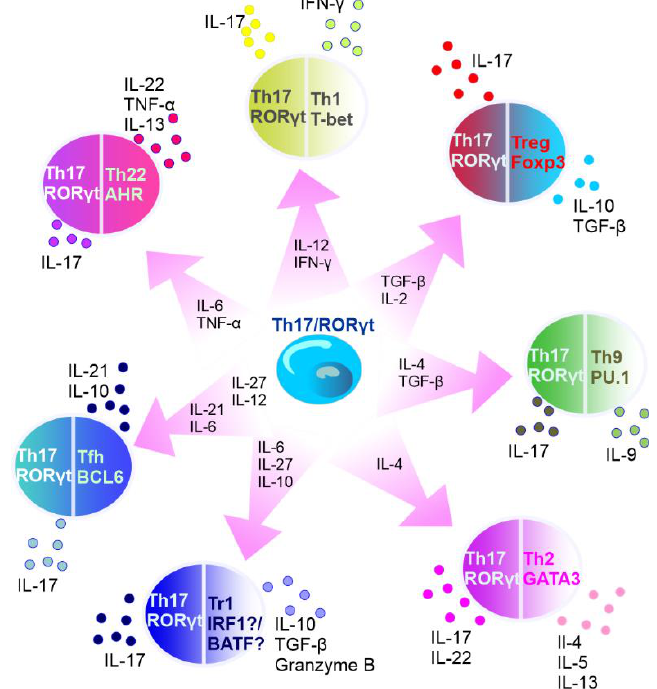
Figure 3. Summary of Th17 cell plasticity. In the circles, the names of T cells are presented with main transcription factors listed below the names. Outside the circles, the cytokines secreted by the specific cells are listed. Transcription factors: AhR—aryl hydrocarbon receptor, ROR γ t—retinoid-acid- receptor-related orphan nuclear receptor γ , IRF1—interferon regulatory factor 1, PU.1—transcription factor encoded by SPI1 gene, BATF—basic leucine zipper transcriptional factor ATF-like, BCL6—B- cell lymphoma 6, T-bet—member of T-box family of transcription factors, GATA3—GATA binding protein 3, and FOXP3—forkhead box P3. Cytokines: IL—interleukin, TNF- α —tumor necrosis